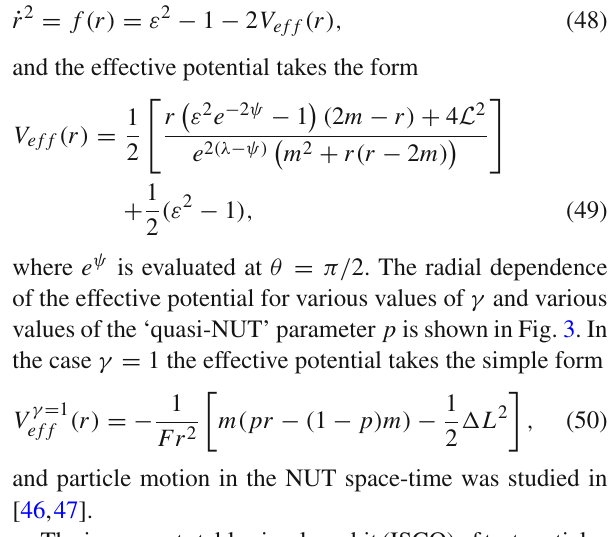
Fig. 2 The line for which g φφ is equal to zero for the stationary ZV space-time. In the outer part of the line g φφ is positive and geodesics with constant t , r and θ are space-like. In the inner part of the line g φφ becomes negative corresponding to appearance of closed time-like curves. The closed time-like curves of the NUT metric, q = 0, in the coordinates of line element (25) are shifted to negative values of r